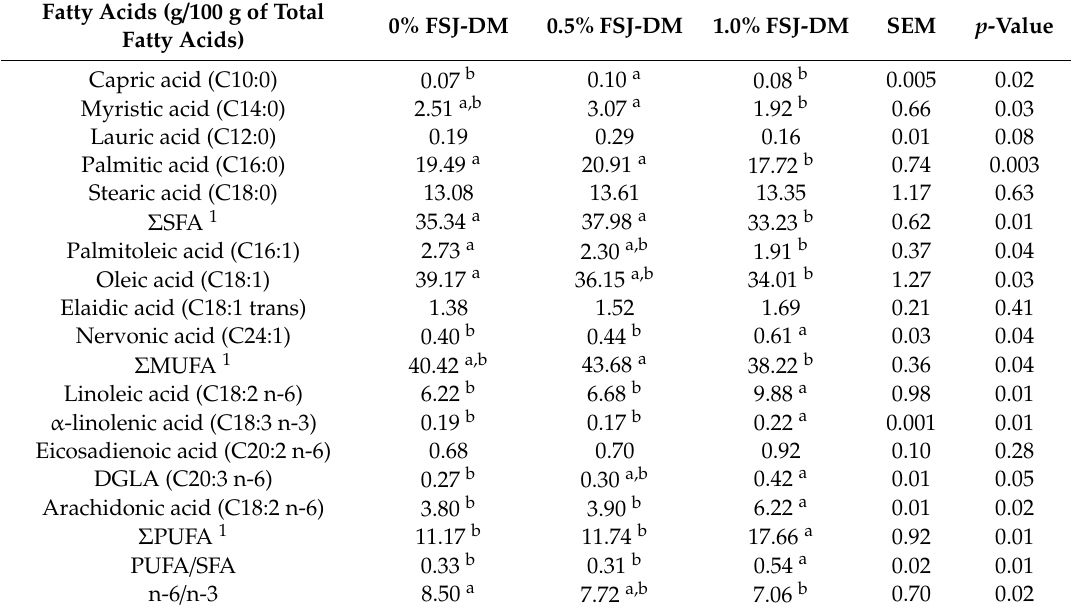
Table 7. Fatty acid composition of gluteus medius muscle (g / 100 g of total fatty acid) from KNBG fed fermented S. japonica and D. morbifera (FSJ-DM).